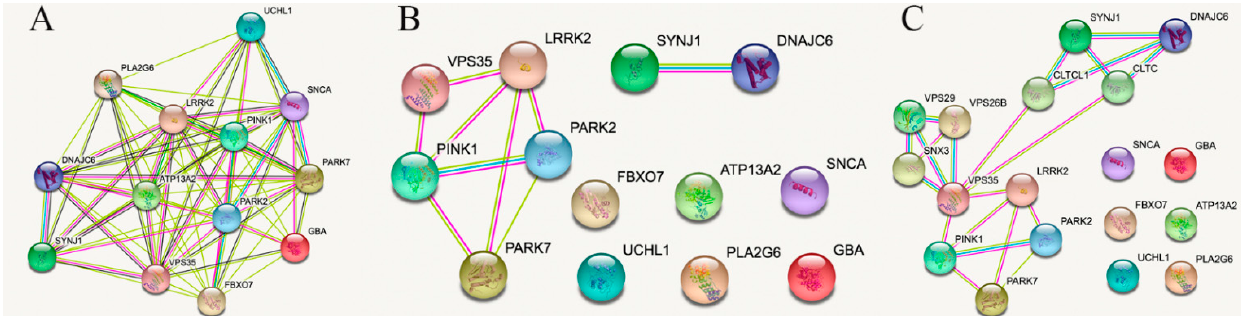
Figure 1. STRING analysis of connections between (human) genes in Table 1. Panel ( A ): using by default settings. Panel ( B ). Restricted settings (mainly leaving aside connections driven by PD-related literature; see text for details). Panel ( C ): Interaction-enriched connection pattern (see text for details). Line color code: sky blue, known interactions from curated databases; magenta, experimentally determined interactions; green, predicted from neighborhood; red, predicted from gene fusions; blue, predicted from gene co-occurrence; pastel green, textmining; black, coexpression; and clear violet, protein homology.